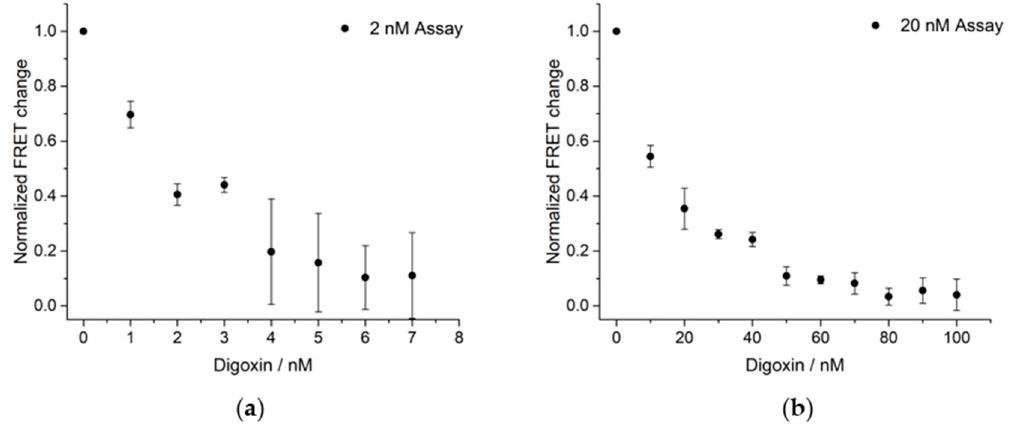
Figure 10. Detection of digoxin in the therapeutic range and comparison with 20 nM assay with overnight incubation. ( a ) A 2 nM assay for detection in the therapeutic range (1.2–2 nM). Normalized FRET change (A:B:S:aD = 1:1:1:1) relative to variable digoxin concentrations (0 to 7 nM) in buffer. All components were mixed at the same time and incubated overnight. Experiments were performed in triplicate. The plotted values are mean values with standard deviations compared to the mean value. ( b ) A 20 nM assay for comparison. Normalized FRET change (A:B:S:aD = 1:1:1:1) relative to variable digoxin concentrations (0 to 100 nM) in buffer. All components were mixed at the same time and incubated overnight. Experiments were performed in triplicate. The plotted values are mean values with standard deviations compared to the mean value.